Question: Identify the chart type used in this figure.
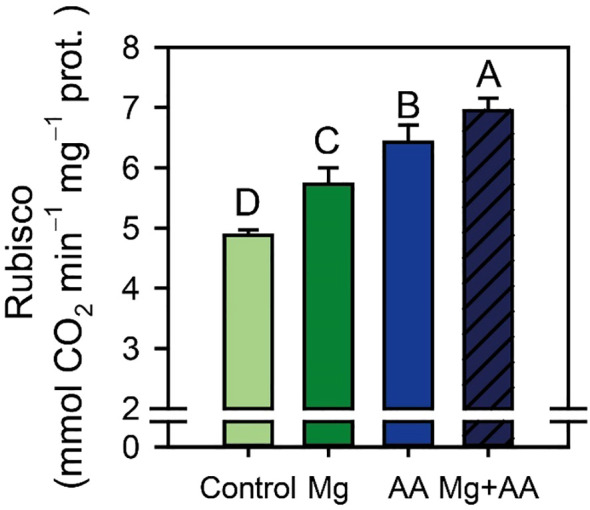
Answer: bar